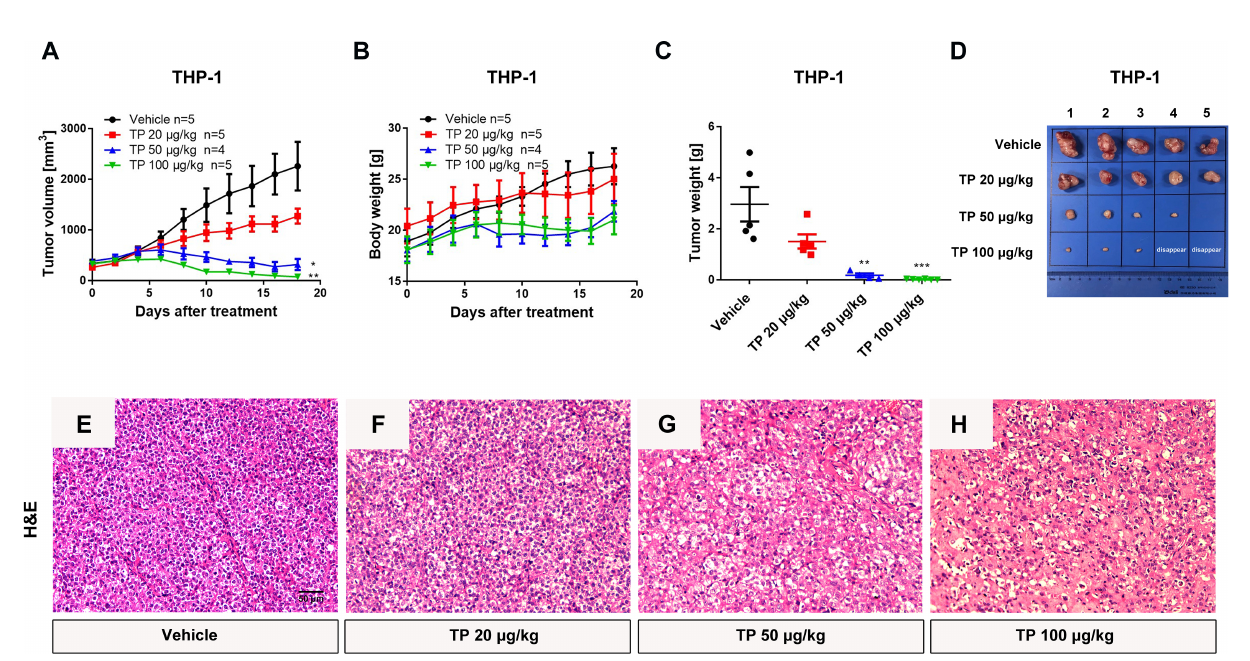
FIGURE 3 | Low-dose triptolide reveals the anti-AML activity in a THP-1 xenograft model. 5×10 6 THP-1 cells were injected into BALB/C nude mice subcutaneously. When the tumor volume reached 100-200 mm 3 , mice were randomly assigned to four treatment groups and treated with triptolide at a dosage of 20, 50, and 100 m g/kg/day via an intraperitoneal injection for 18 consecutive days. Tumor volume (A) and bodyweight (B) was measured every other day. At the end of the study, tumors were weighed (C) and photographed (D) . * p < 0.05; ** p < 0.01; *** p < 0.001; (E – H) Representative photos of tumor sections stained with H&E were